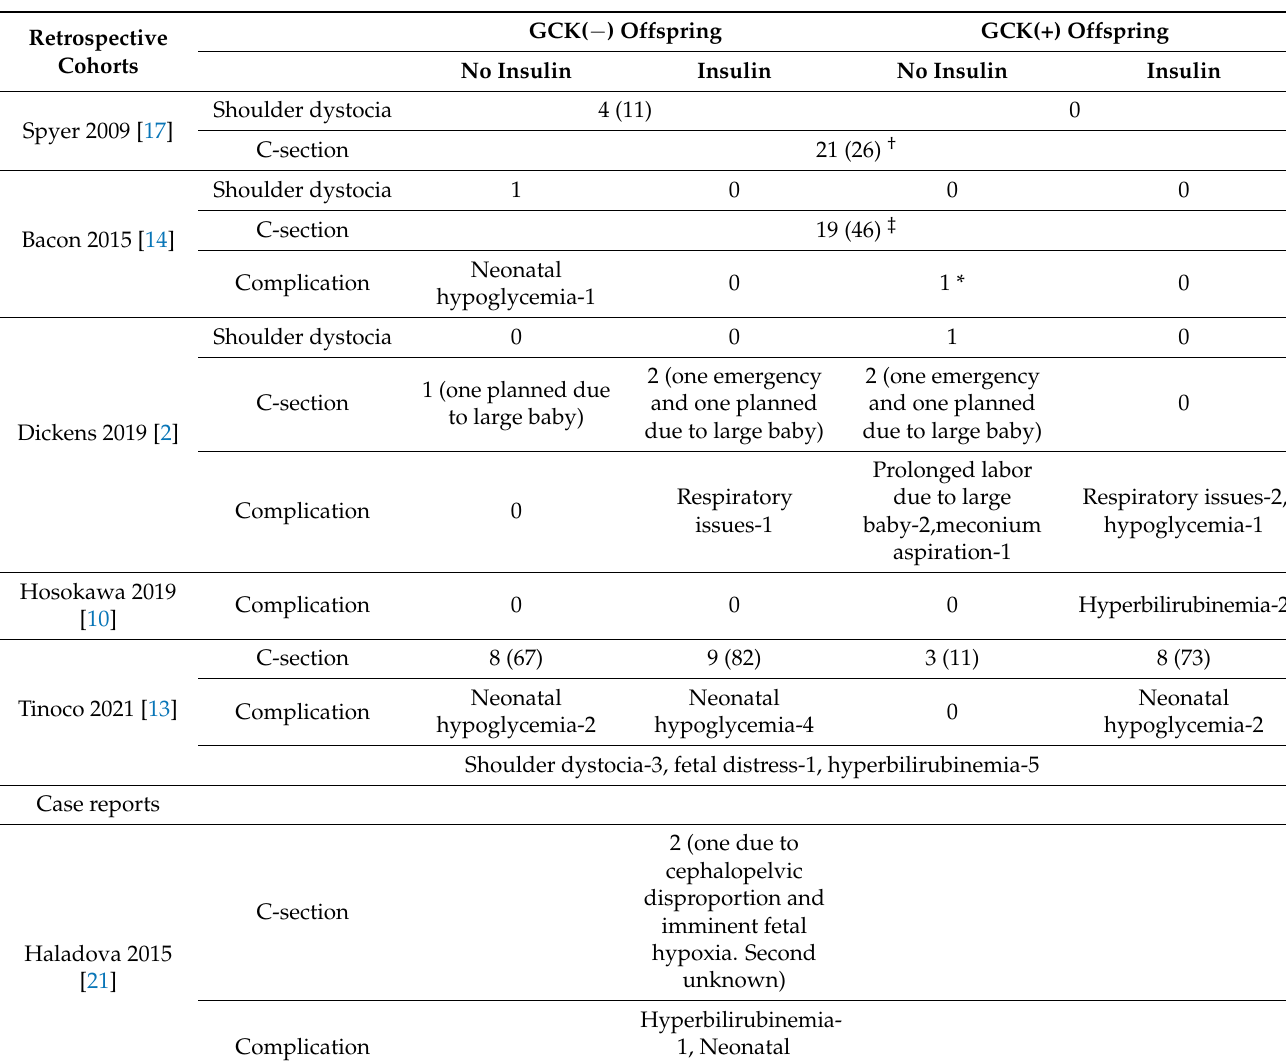
Table 5. Available Data on Pregnancy